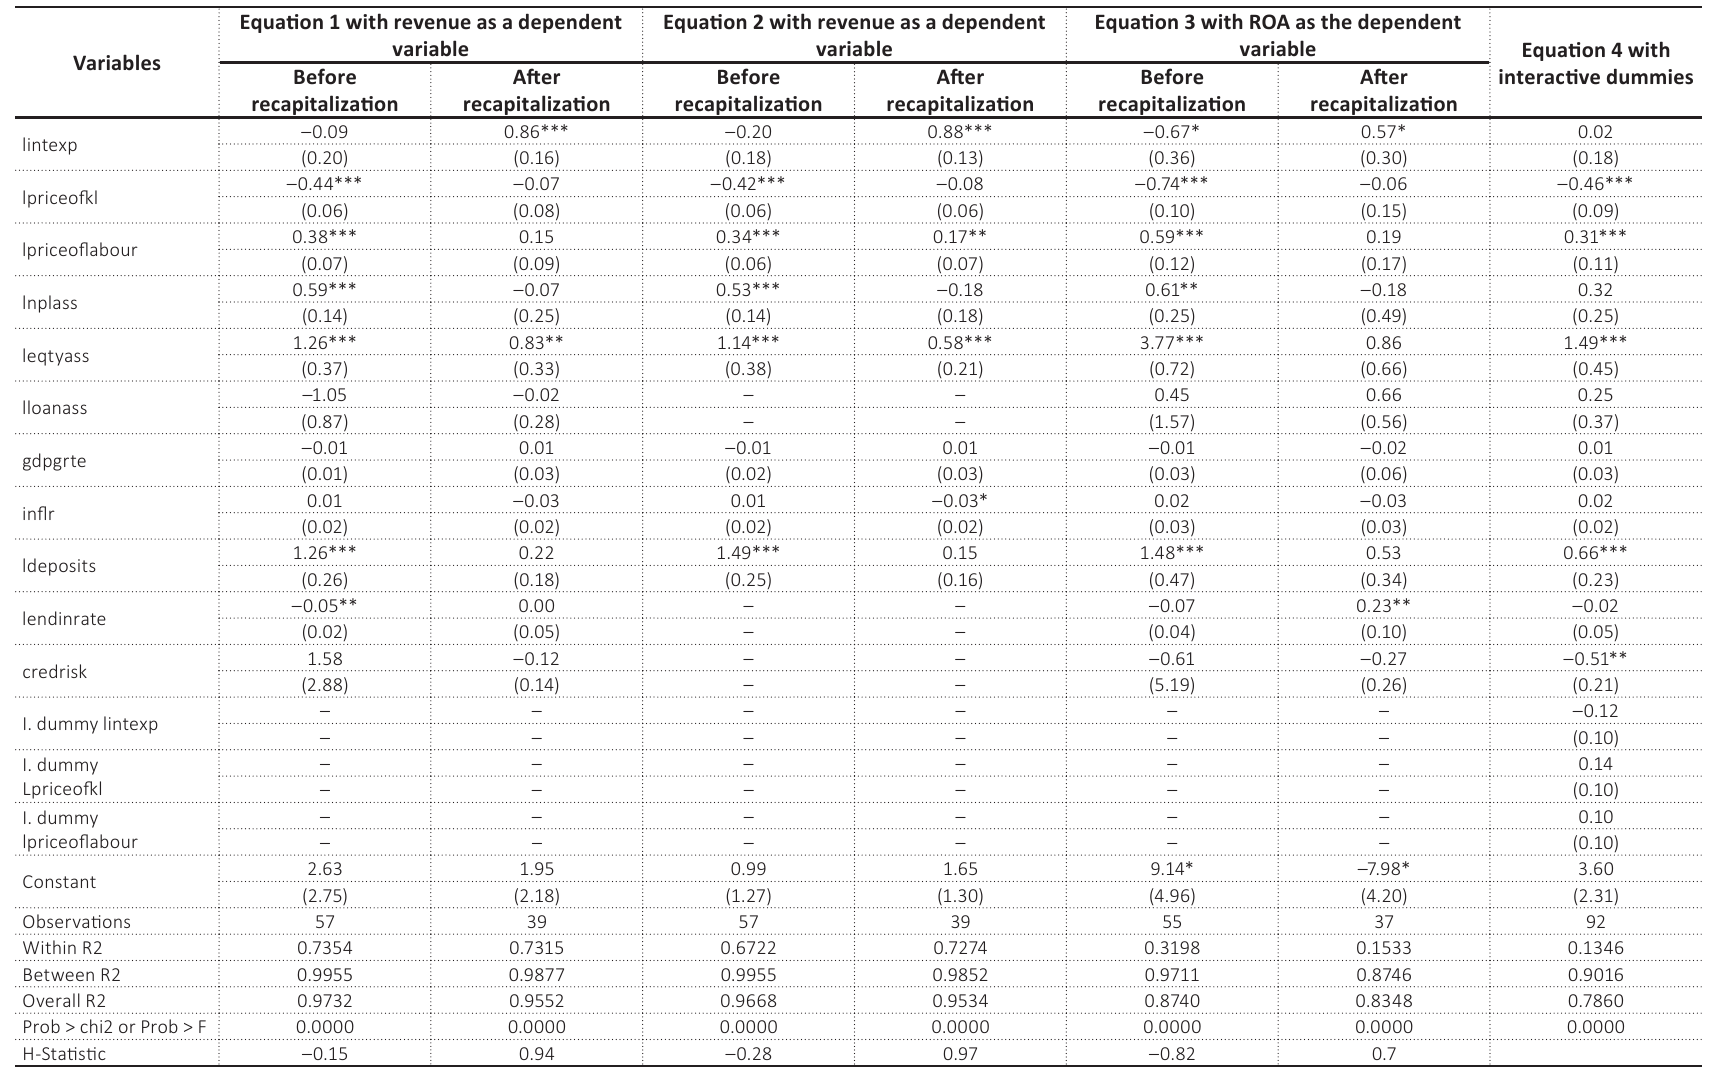
Table 4. Panzar-Rosse estimation results for